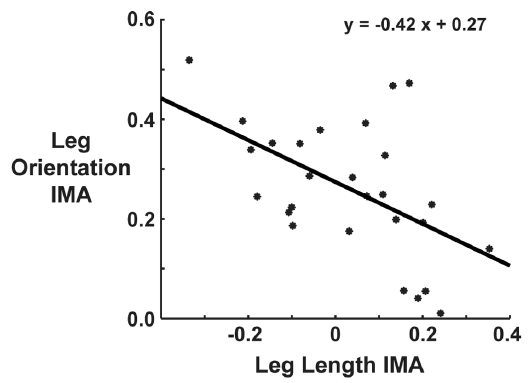
Figure 5. Relationship of leg orientation versus leg length stabilization. IMA’s for leg orientation stabilization and leg length stabilization for all subjects and conditions showed a significant negative linear correlation (p=0.03). Increases in leg orientation IMA with decreases in leg length IMA corresponds with smaller target